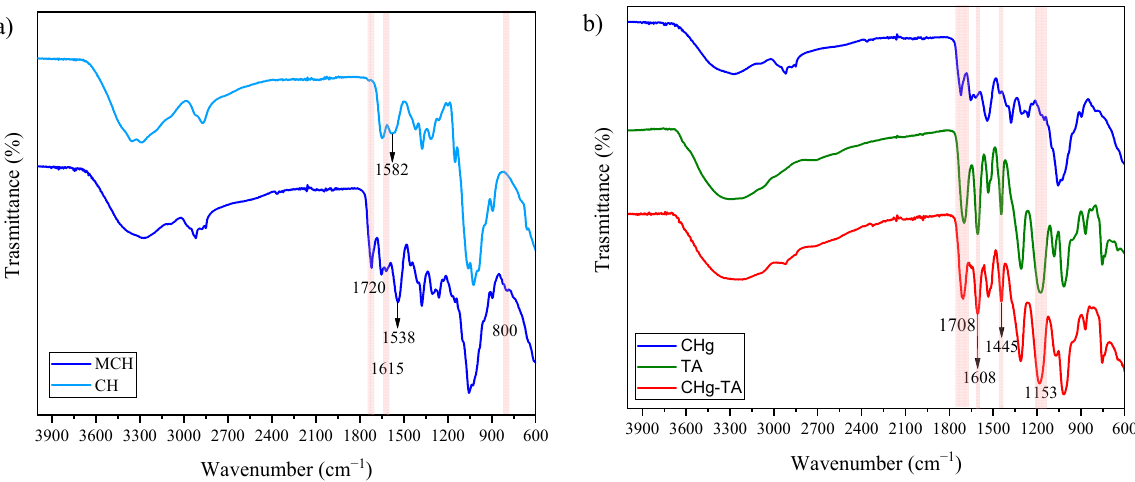
Figure 2. FTIR spectra of ( a ) chitosan before and after the methacrylation reaction and ( b ) CHg-TA, compared to CHg and TA powder.